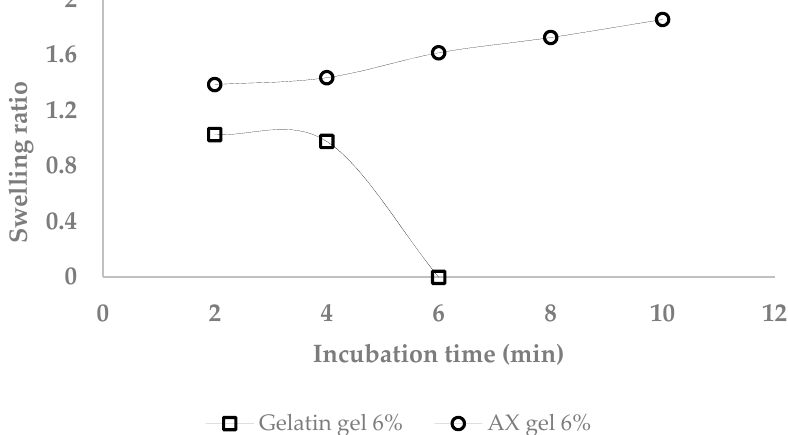
Figure 10. Swelling ratio of gelatin (6%) and arabinoxylan gel (6%) in artificial saliva at room temperature.